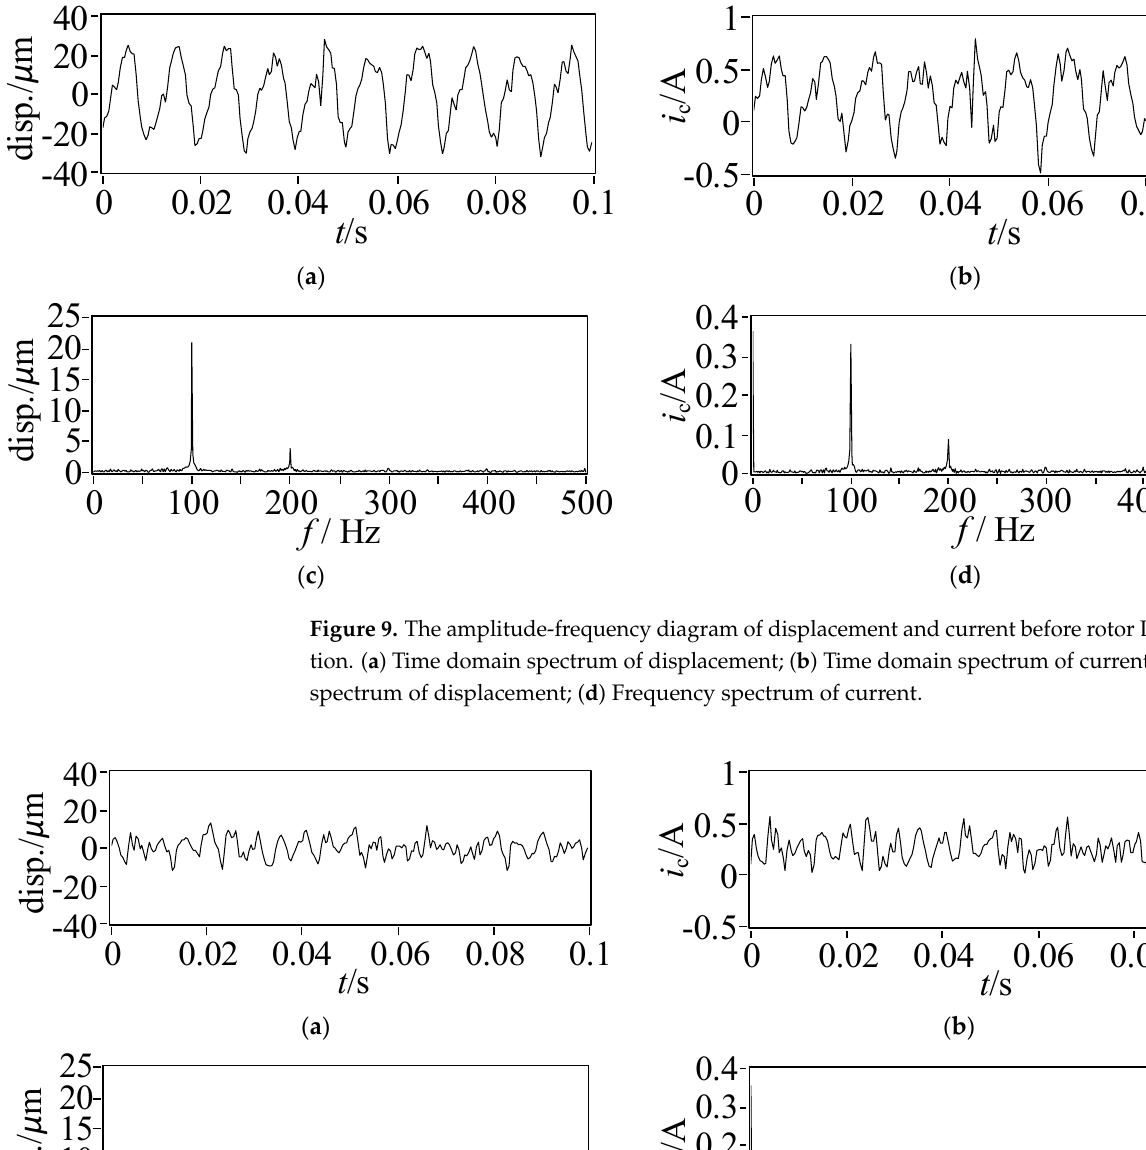
( b ) Figure 8. LMS compensation process. ( a ) displacement diagram; ( b ) current graph. It can be seen from Figures 9 and 10 that before compensation, due to the unbalanced vibration of the rotor, to compensate for the vibration, the controller outputs the control current in real-time. From the spectrum diagram, it can be seen that the main frequency components in the rotor displacement and the magnetic bearing control current are in synchronous frequency with the speed. That is, the main factor affecting the rotor vibra- tion is unbalanced vibration, and the main component of the magnetic bearing control output is also the unbalanced control current with the synchronous frequency. After com- pensation, the co-frequency control current of the rotor is reduced by 92%, close to 0. And